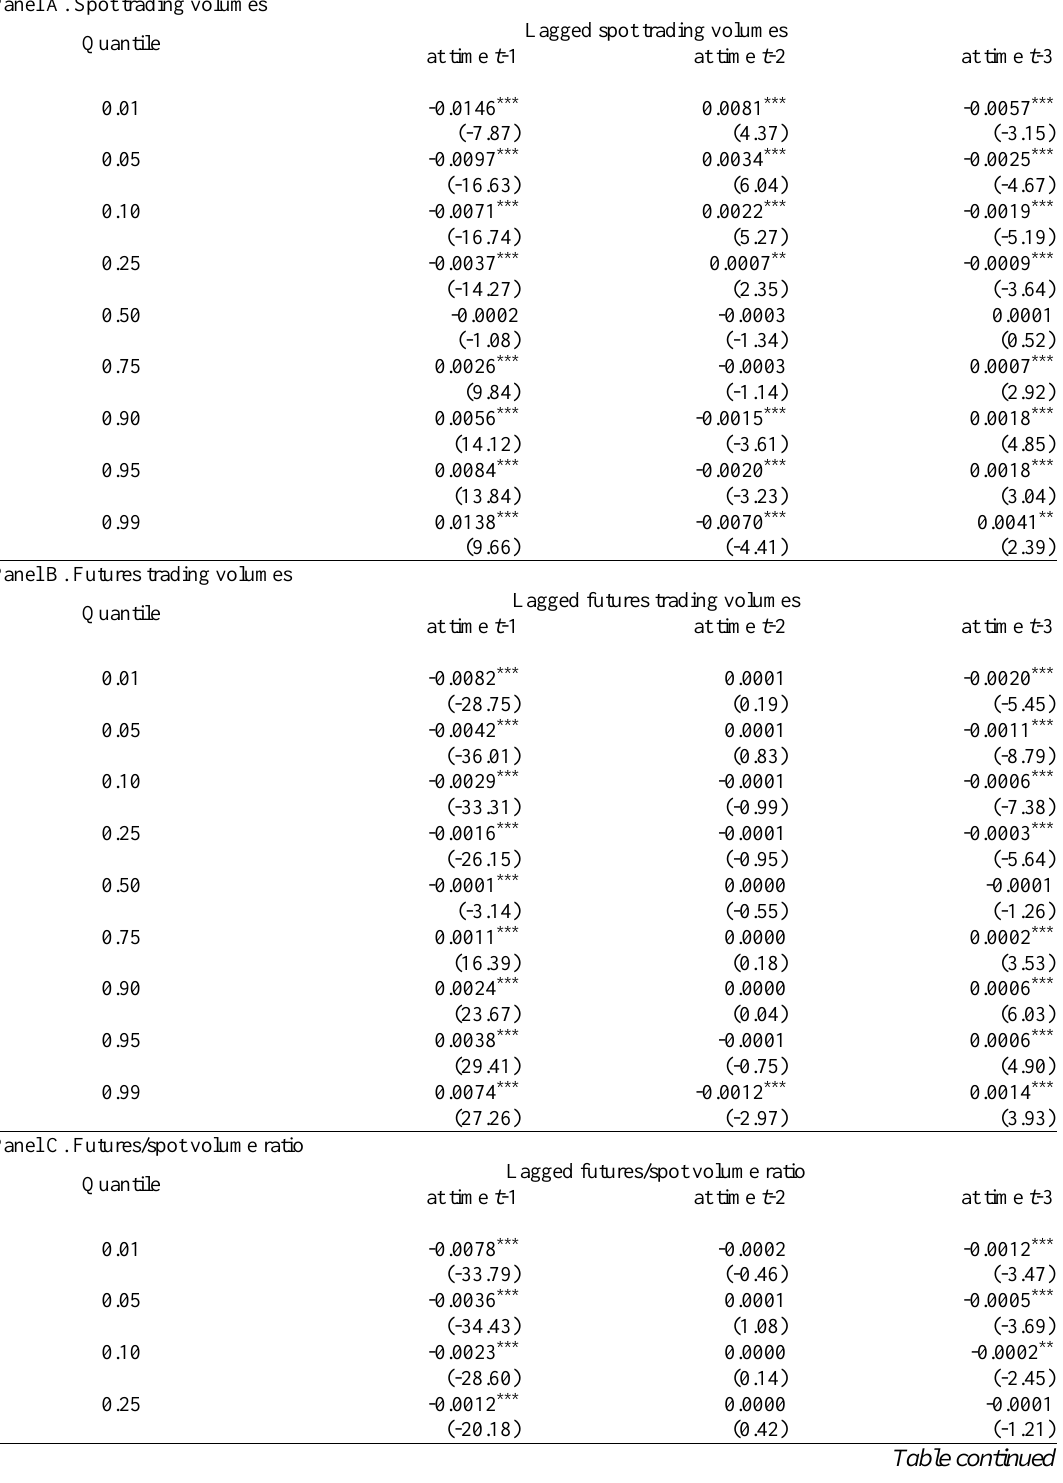
Table 2: Return-quantiles and trading-volumes